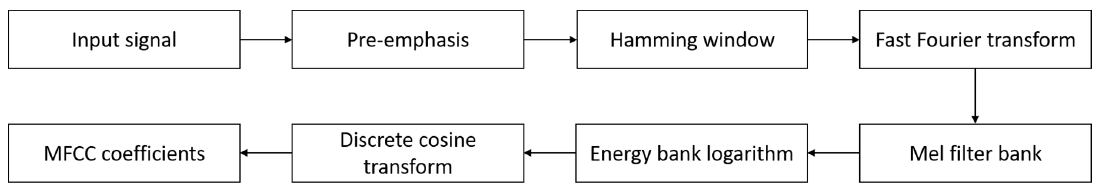
ffi cient (MFCC) computation Figure 6. The general Mel Frequency Cepstral Coefficient (MFCC) computation steps. Figure 6. The general Mel Frequency Cepstral Coe Figure 6. The general Mel Frequency Cepstral Coefficient (MFCC) computation steps. Figure 6. The general Mel Frequency Cepstral Coefficient (MFCC) computation steps.